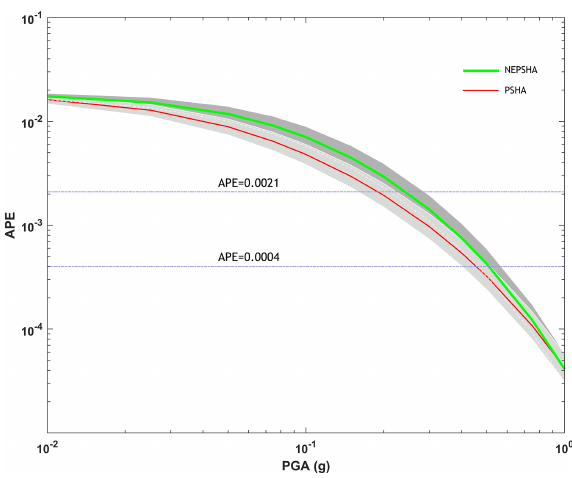
Figure 3. Hazard curves and 95% confidence intervals based on PSHA and NEPSHA approaches for peak ground acceleration